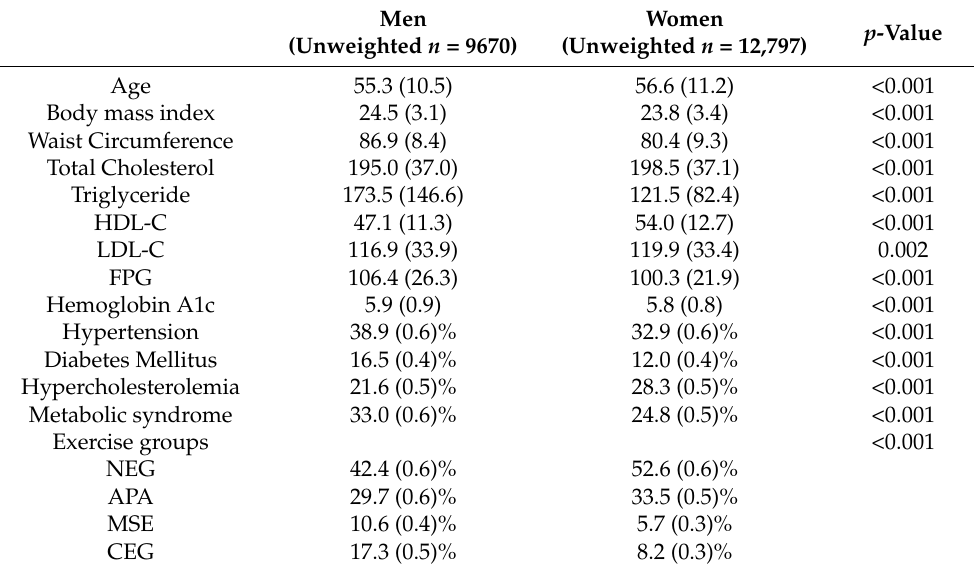
Table 1. General characteristics of study